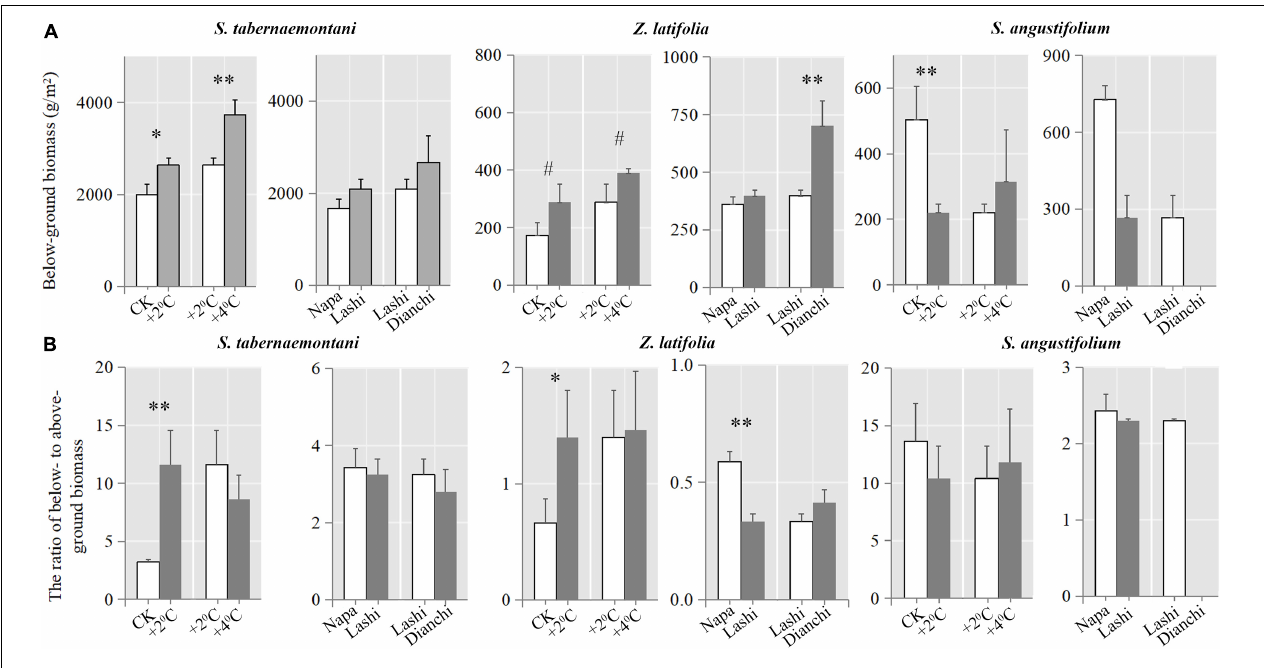
FIGURE 7 | (A) Below-ground biomass and (B) the ratio of below- to above-ground biomass of the three species ( S. tabernaemontani , Z. latifolia , and S. angustifolium ) determined at the end of the warming experiments. Error bars indicate standard deviations. Significant differences between Treatments are indicated by asterisks ( ∗∗∗ p < 0.001; ∗∗ p < 0.01; ∗ p < 0.05; # p < 0.1). Note that S. angustifolium disappeared in Dianchi at the end of the experiment, and comparisons between Lashi and Dianchi were not